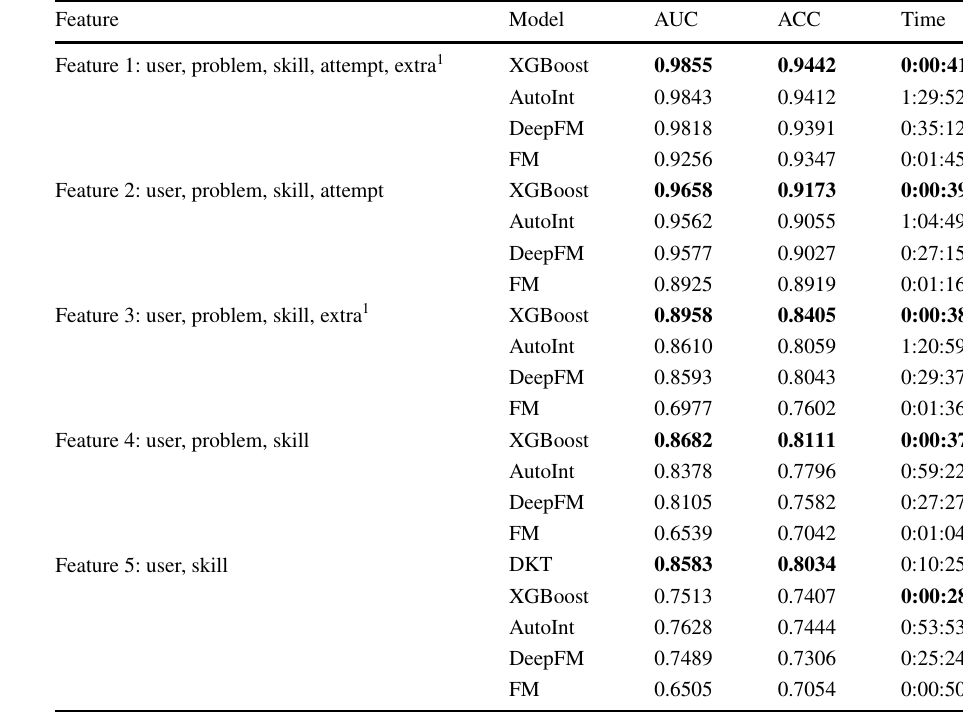
Table 8 The experimental results for ASSIST09